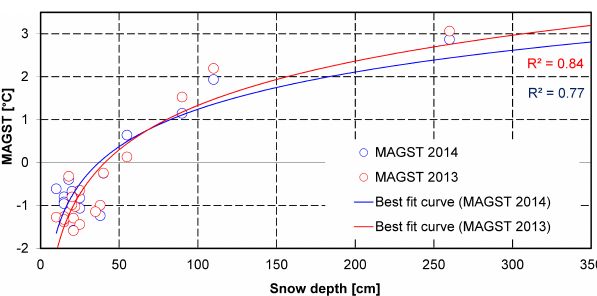
Figure 11. Relationship between the snow height measured in April 2014 and the mean annual ground surface temperature (MAGST) in 2013 and